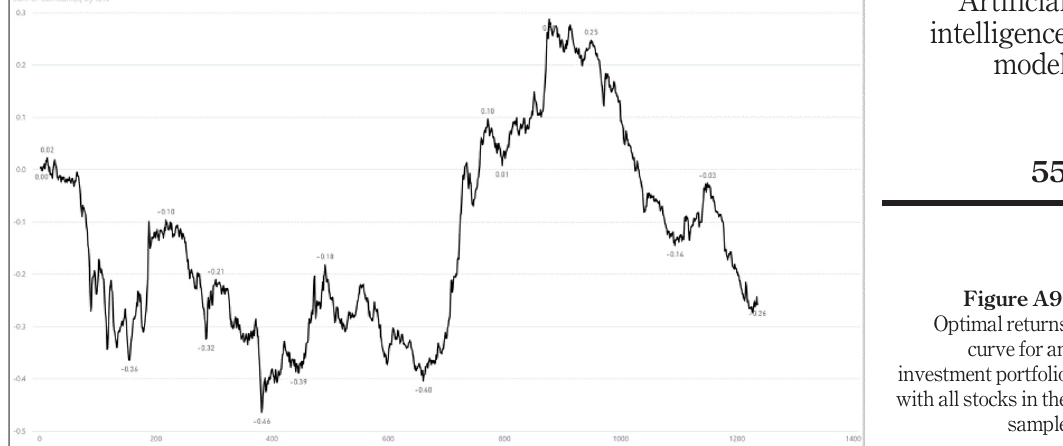
Figure A9. Optimal returns curve for an investment portfolio with all stocks in the sample